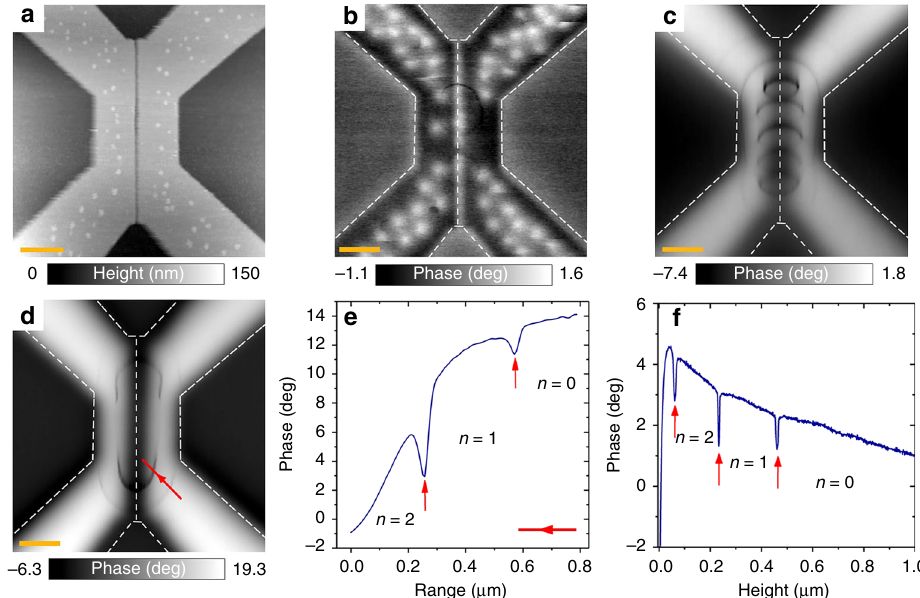
Fig. 2 Detection of Josephson vortices. a Topographic AFM image of the device. The orange scale bar corresponds to 0.5 μ m. ( a – c ) MFM phase maps (dashed lines represent the edges of the device): b when the device is fi eld-cooled in 90 Oe (tip lifted by 150 nm). The areas with screened (enhanced) fi eld appear in black (white); small round white spots are individual Abrikosov vortices pinned in Nb. c when a 90 Oe fi eld is applied to the zero- fi eld cooled device (tip lifted by 70 nm). Meissner currents screen the magnetic fi eld in Nb; no Abrikosov vortex are present. Several black rings appear near the junction area representing sharp phase drops occurring when the tip is positioned in speci fi c locations. The rings delimit regions of speci fi c Josephson vortex con fi gurations inside the junction affected by the local magnetic fi eld of the tip (see in the text). d when no fi eld is applied to zero- fi eld cooled device (tip lifted by 70 nm). A few black arcs are visible, demonstrating the effect of the self- fi eld of the magnetic tip on the junction. e spatial variation of the phase signal along the line represented by the red arrow on the map d . Each phase drop (vertical red arrows) delimits different Josephson con fi gurations with the vortex numbers n = 0, 1, 2 (see in the text). f evolution of the phase as a function of the tip height (tip-surface distance) when the tip is positioned above the center of the device. Red arrows and vortex numbers n = 0, 1, 2 — the same as in